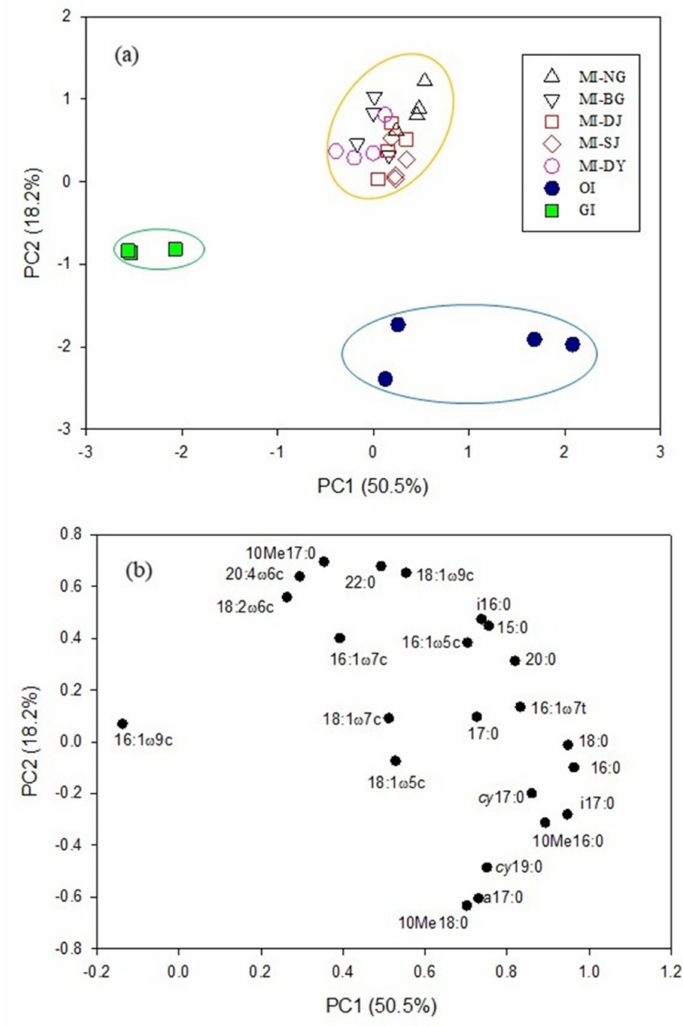
Figure 2. Plots of the first two principle components (PCs) from the principal component analysis of the mole % of microbial phospholipid fatty acid content of soil samples of different island. ( a ) Sample distribution of the first two PCs. ( b ) Corresponding loading values of fatty acid distribution of two